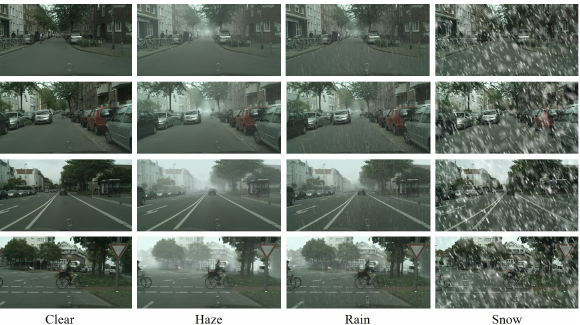
Figure 3. Sample scenes from the Cityscapes and rearranged Cityscapes weather datasets. We com- bined images selected from Foggy Cityscapes [49], Rain Cityscapes [50], Snow Cityscapes [31], and the original Cityscapes [48] datasets into one corpus consisting of 5000, 3540, 6000, and 5000 images from each dataset, respectively. The number of samples from each dataset varied due to variation in our synthesis strategy for different weather types. The original resolution of all the images is 2048 ×